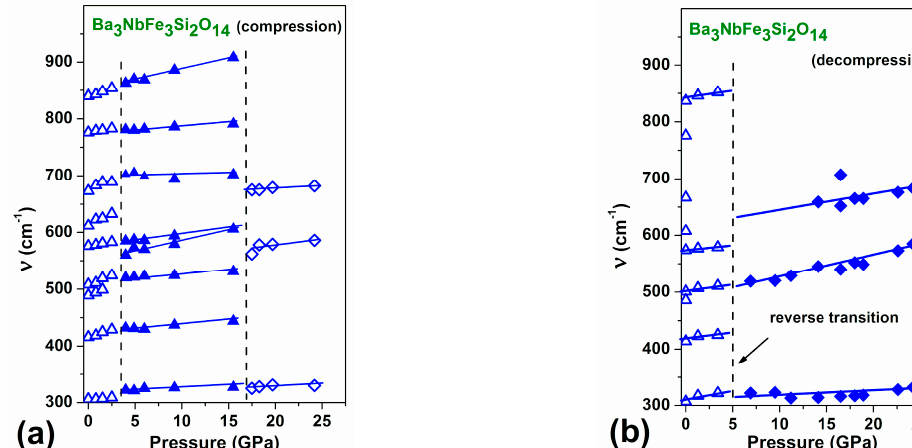
Figure 4. (Colour online) Raman spectra of Ba 3 NbFe 3 Si 2 O 14 at different pressures up to P = 24 GPa at compression ( a ) and decompression ( b ).